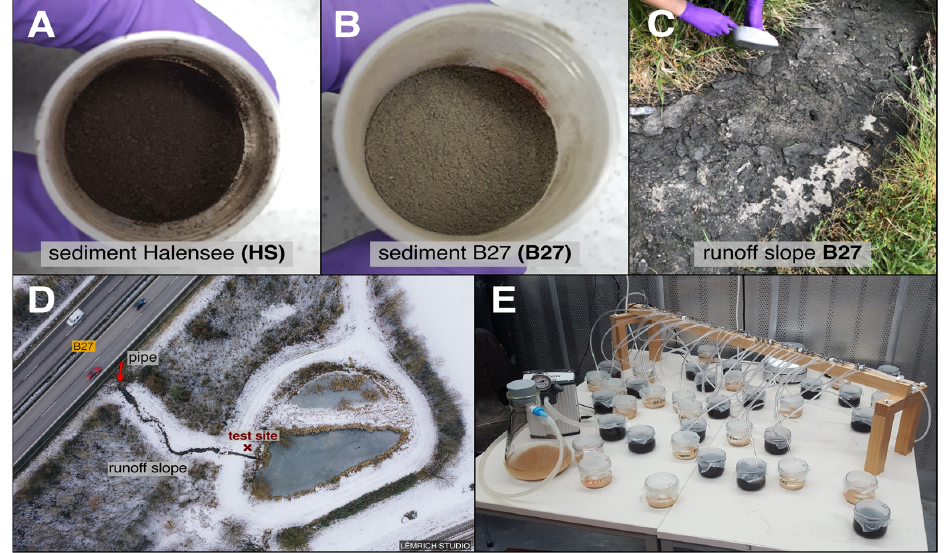
Figure 1. The dried and pulverized test sediments, the test site B27, and the experimental setup for the ventilation experiments. ( A ) The black sediment from HS, as provided by the UFZ Leipzig (sample taken directly from the settling pond on 06.12.2018). ( B ) The dark grey sediment from B27, collected from the runoff slope to the settling pond (28.04.2020, 07.08.2020, and 15.11.2020). ( C ) Sample collection from the runoff slope (B27). The accumulated TRWP-containing sediment could be scraped off in layers. ( D ) Drone footage of the settling pond at the B27, taken from above (19.01.2022) by LÊMRICH STUDIO. The road, the runoff slope, and the test site are indicated. ( E ) Setup of the experiments (in a climate-controlled chamber; 20 °C, light–dark cycle of 12:12 h), where 50% of the treatments and the control were artificially ventilated with an air pump connected to rubber hoses and glass pipettes. In the left corner, the vacuum flask with low oxygen control (negative pressure, NP) can be seen (100 mbar).